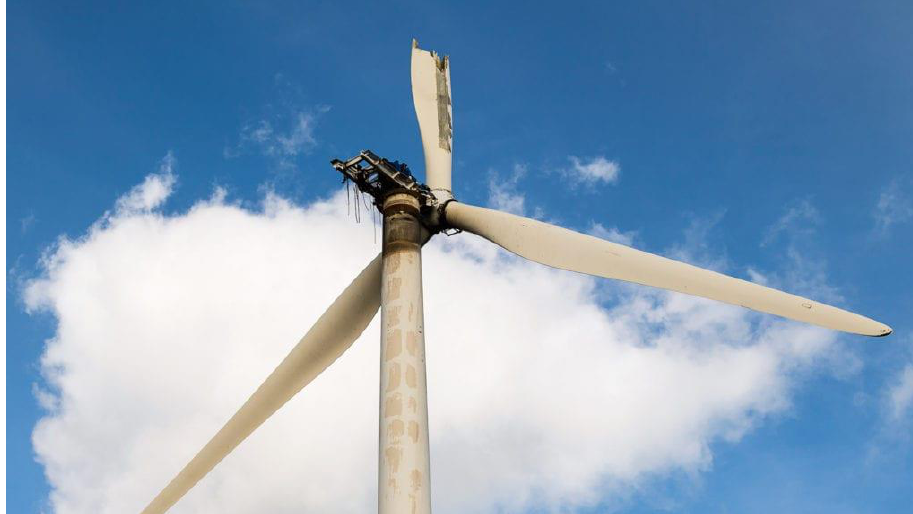
Figure 2. Severe wind turbine damage due to lightning